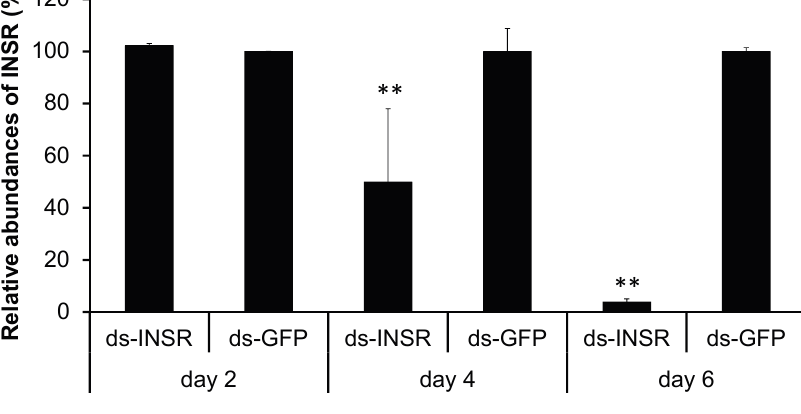
Figure 5. Relative abundance of Bm-INSR genes after dsRNA injection. Ds-GFP signifies the negative control groups. ds-INSR represents dsRNA treated groups. Asterisks indicate statistically significant difference ( t -test, p < 0.01). The gene expressions were examined using quantitative real time PCR. The gene RP49 was used as the internal